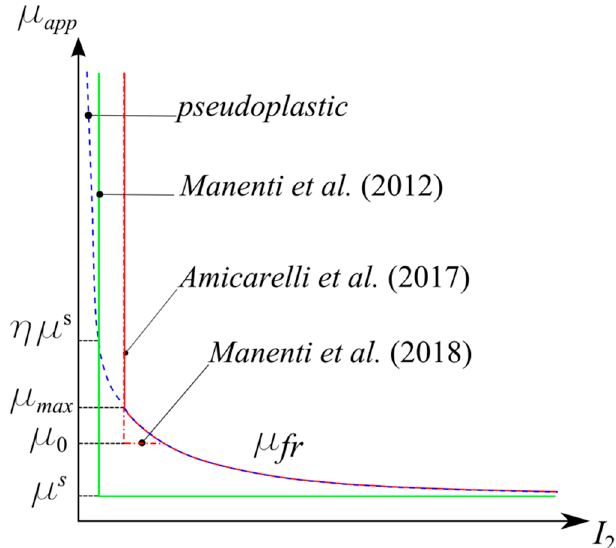
Figure 1. Rheological models for non-cohesive sediment erosion with bed load transport and for dense granular flows. I 2 : second invariant of the rate of deformation tensor; µ app : apparent viscosity.